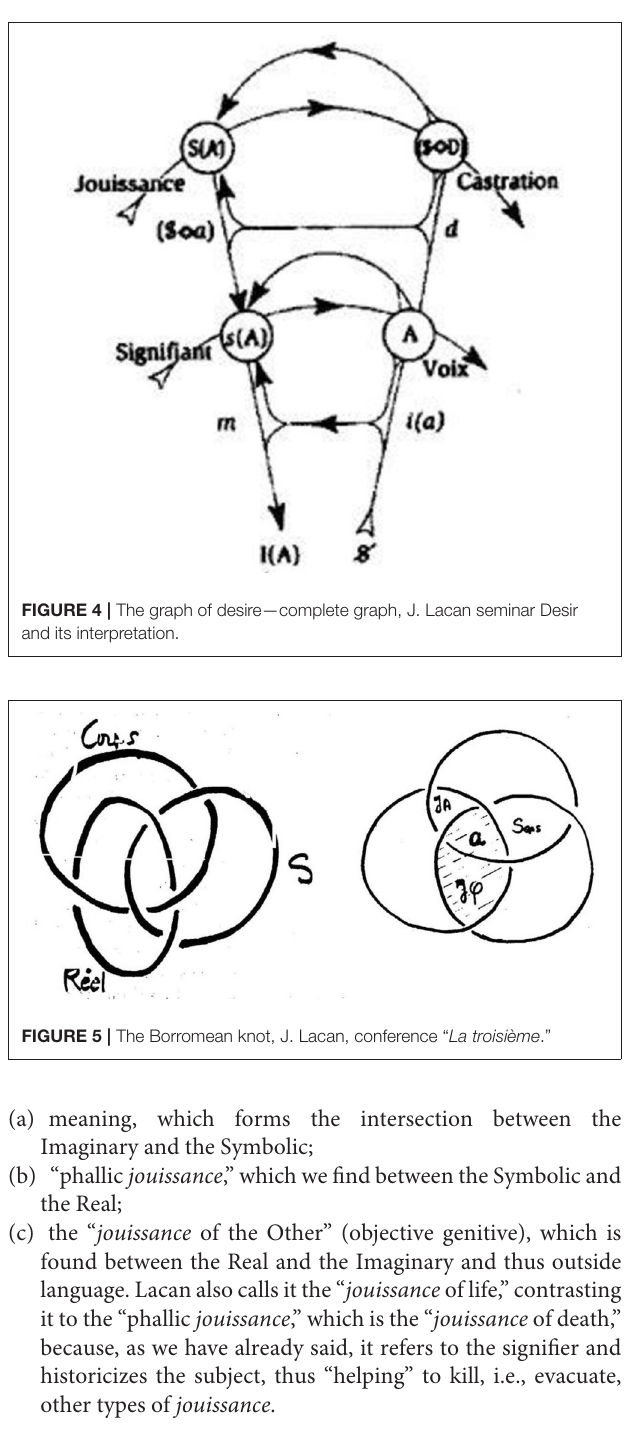
(a) meaning, which forms the intersection between the Imaginary and the Symbolic; (b) “phallic jouissance ,” which we find between the Symbolic and the Real; (c) the “ jouissance of the Other” (objective genitive), which is found between the Real and the Imaginary and thus outside language. Lacan also calls it the “ jouissance of life,” contrasting it to the “phallic jouissance ,” which is the “ jouissance of death,” because, as we have already said, it refers to the signifier and historicizes the subject, thus “helping” to kill, i.e.,